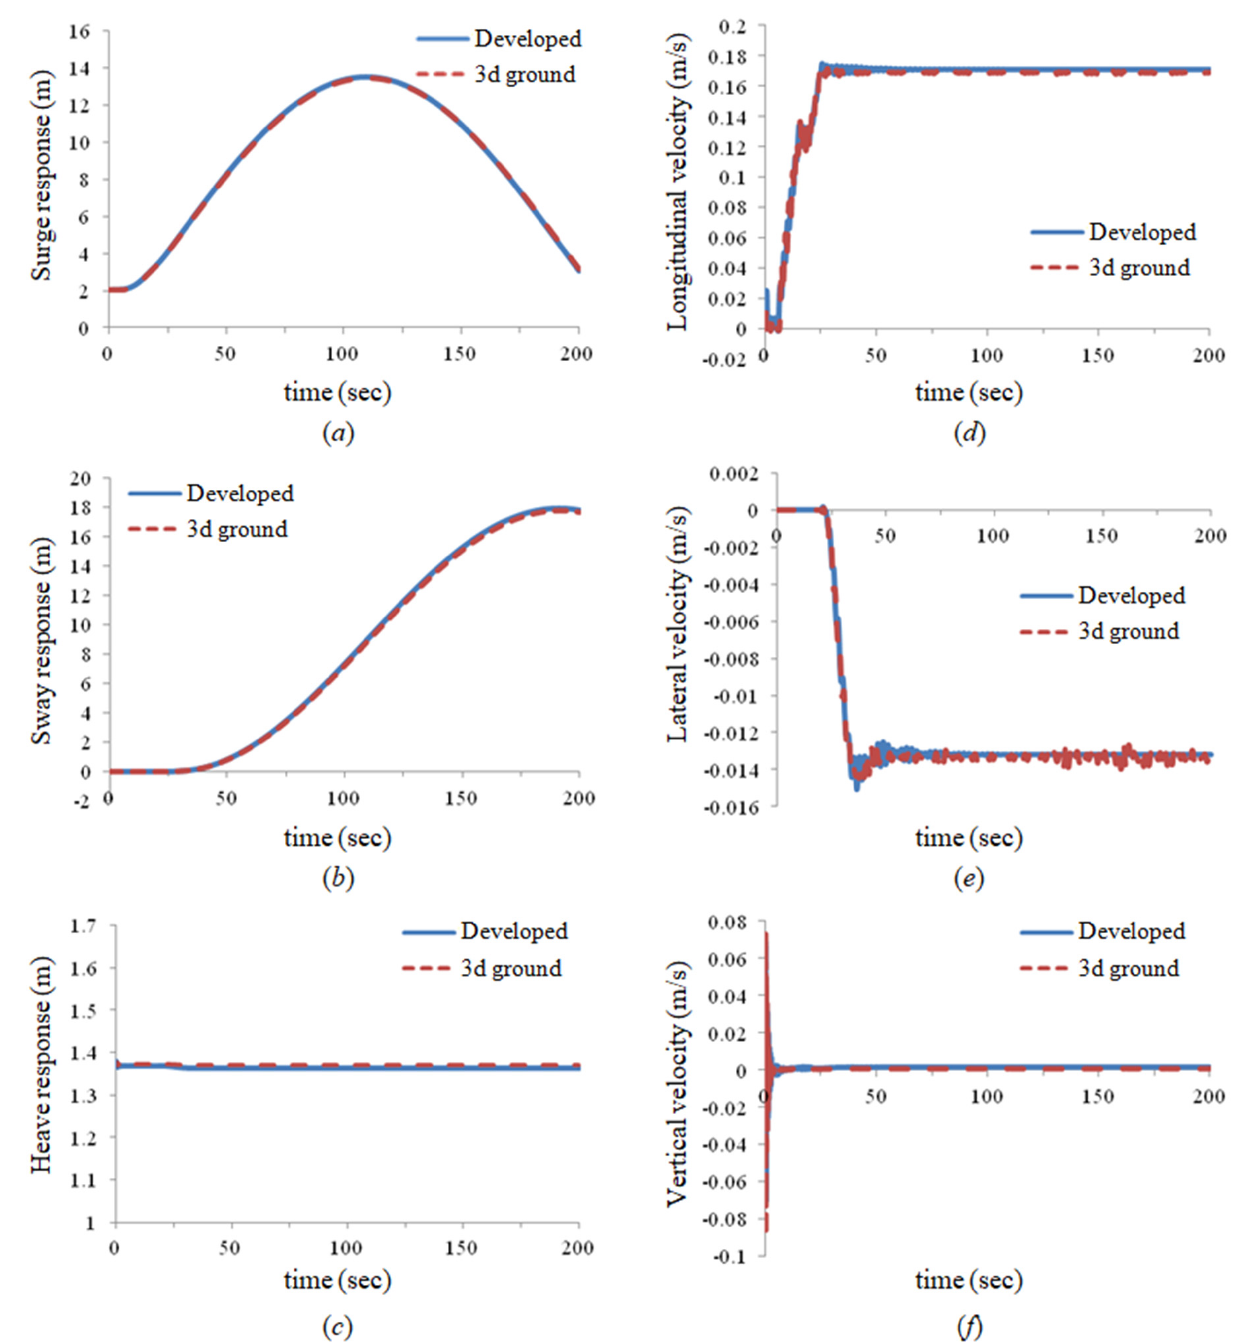
Figure 33. Comparison of the steering drive dynamic analysis results between the developed method and 3D ground model: ( a ) surge response of the mining robot, ( b ) sway response of the mining robot, ( c ) heave response of the mining robot, ( d ) longitudinal velocity of the mining robot, ( e ) lateral velocity of the mining robot, ( f ) transverse velocity of the mining robot.